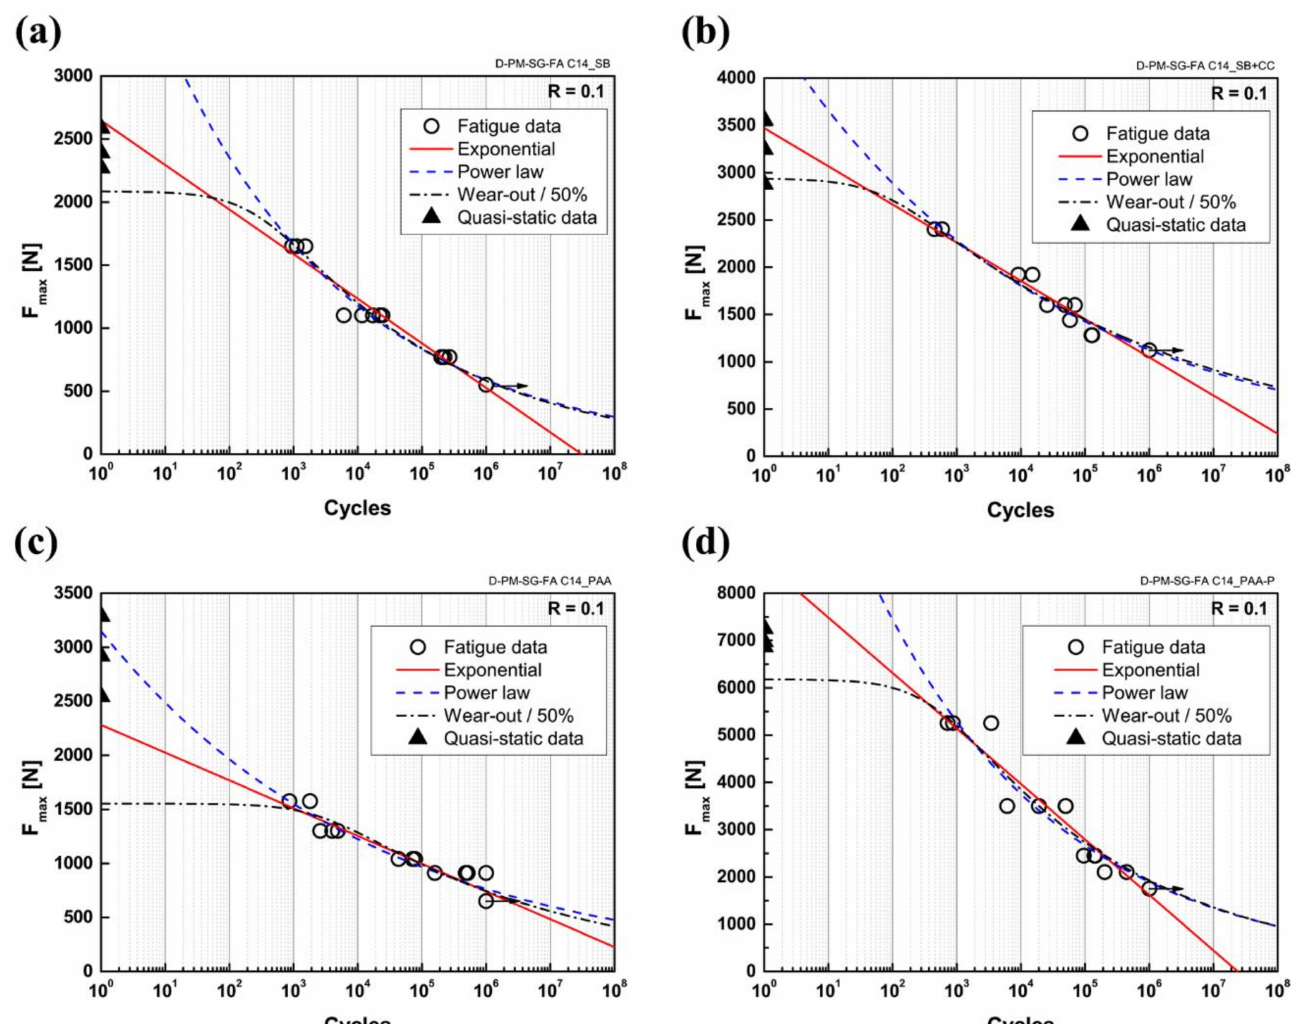
Figure 3. Derived S–N curves based on exponential, power-law, and wear-out models for the ( a ) SB, ( b ) SB + CC, ( c ) PAA, and ( d ) PAA-P